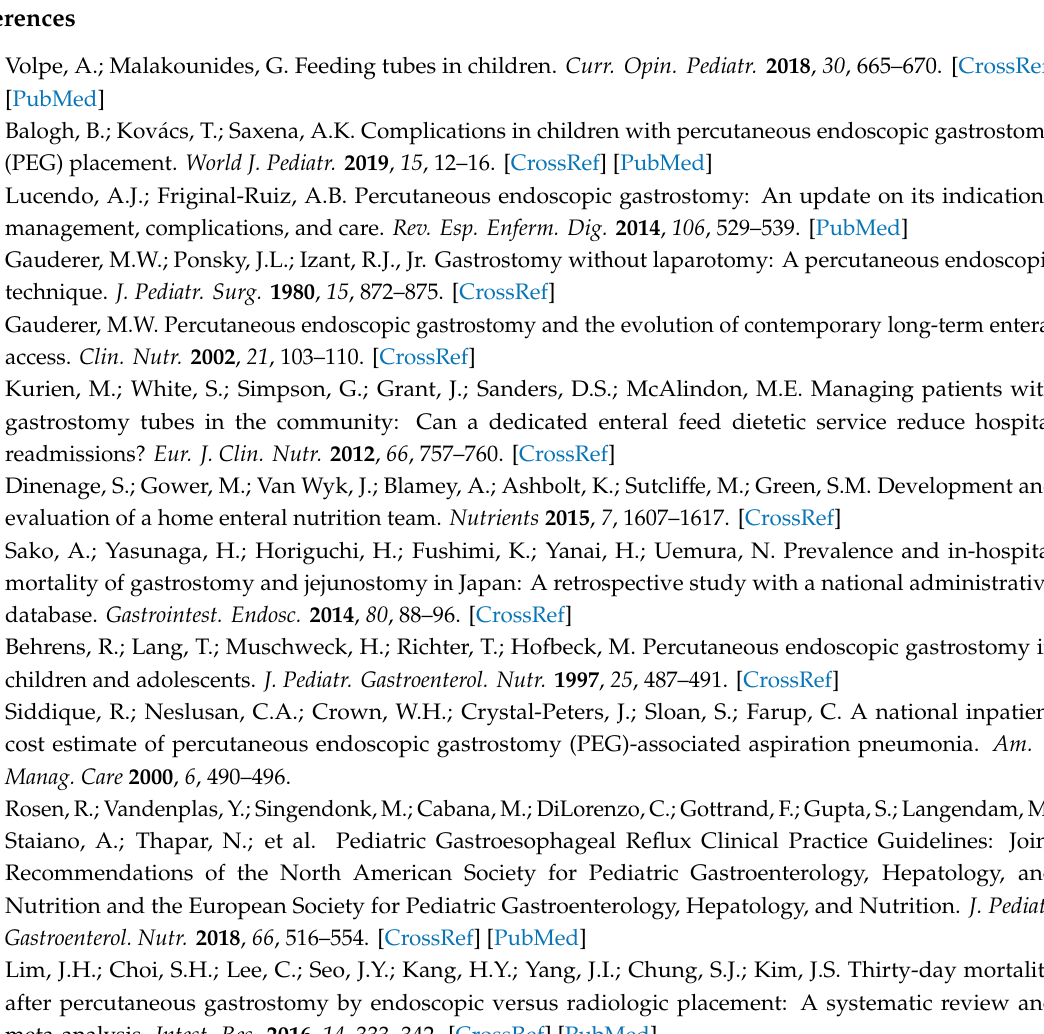
Figure A4. Forest plot of the hospital stay for children managed with and without antibiotics.